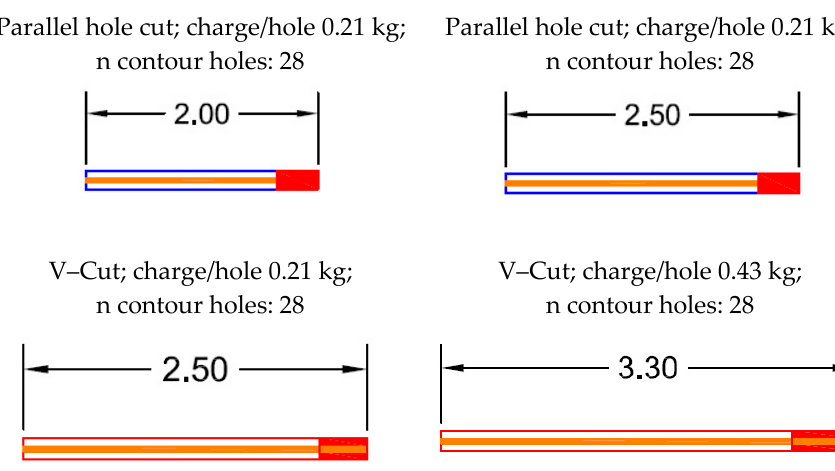
Figure 16. Details of the charges employed in contour holes [4].